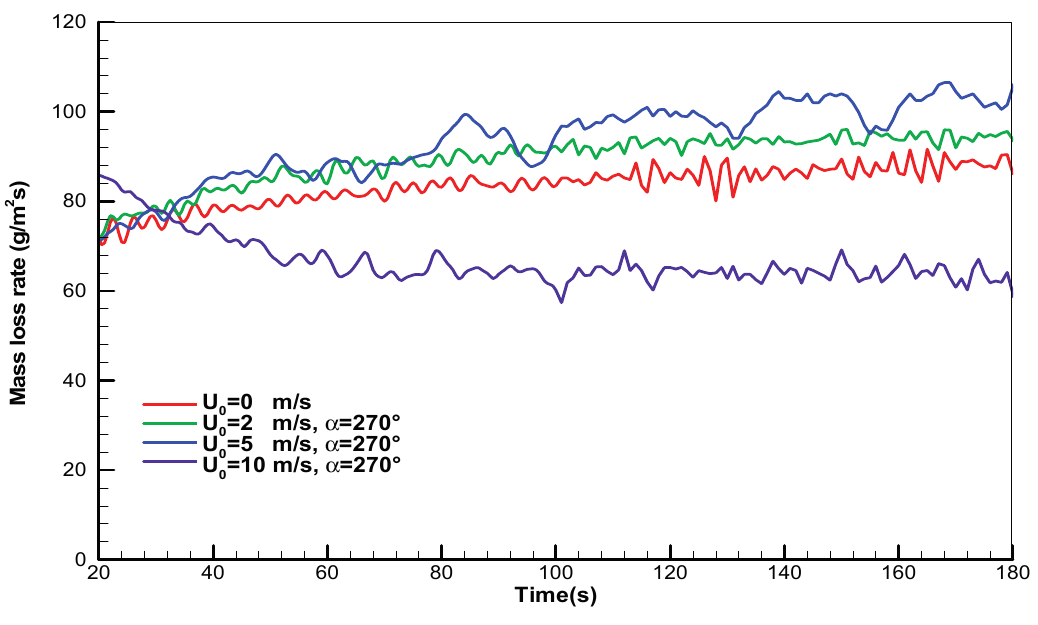
Figure 20. History of the mass loss rate of the liquid fuel during the fire propagation over the composite-type aircraft for the different wind